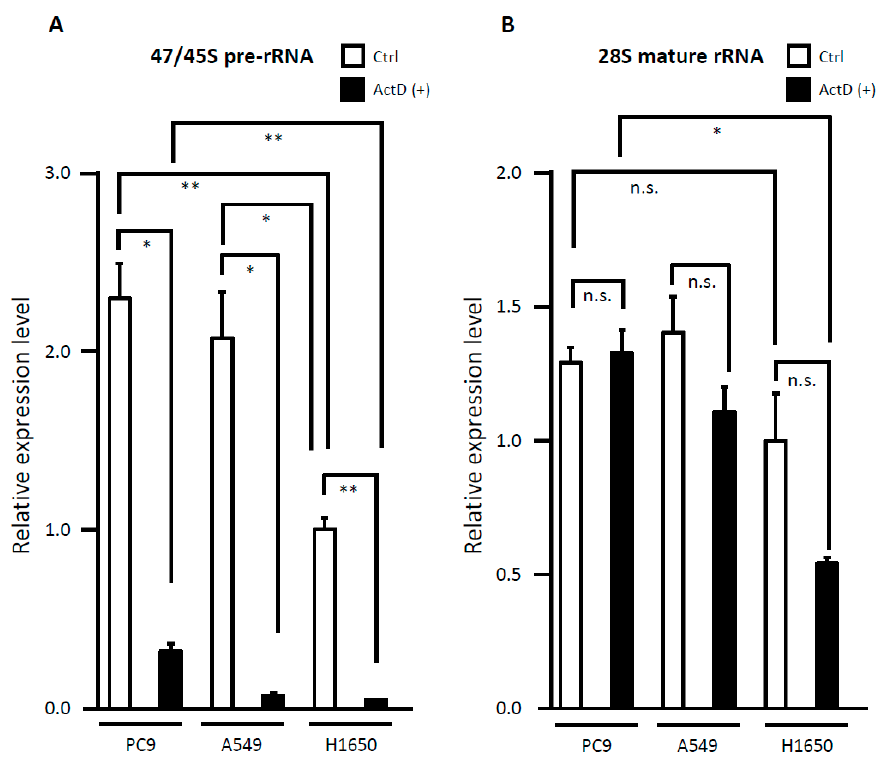
Figure 8. Evaluation of rRNA expression and the effect of low-dose Actinomycin D (50 ng/mL, 2 h) treatment in lung adenocarcinoma cell lines. ( A ) 47/45S precursor ribosomal RNA (pre-rRNA) and ( B ) 28S mature rRNA. Relative transcription level of untreated H1650 cells was assumed as 1. n.s., not significant; * p < 0.05; ** p < 0.01.